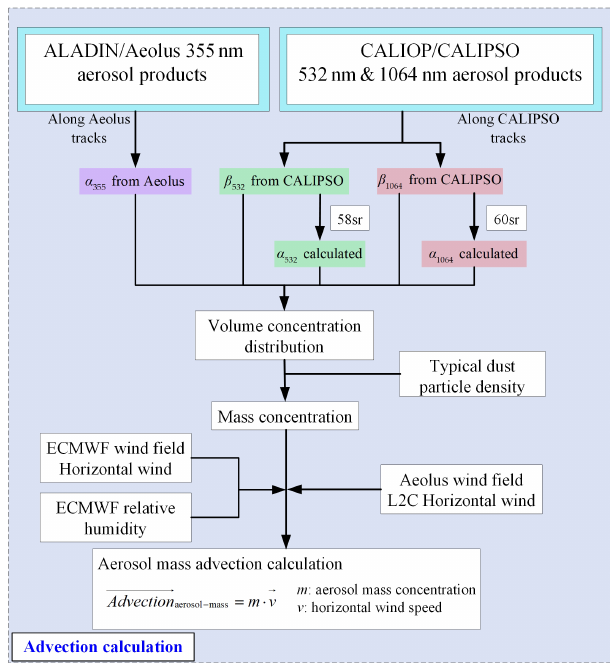
Figure 2. The flowchart of the dust mass advection calculation pro-